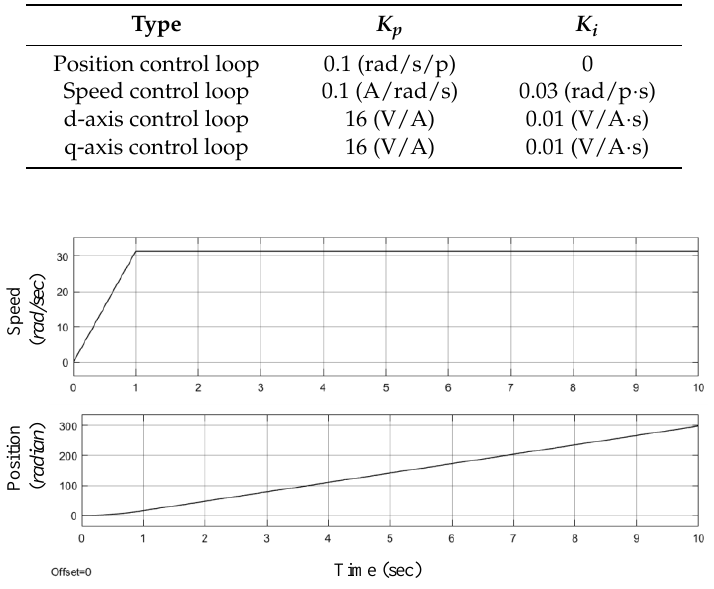
Figure 8. The speed and position responses by pulse generator.